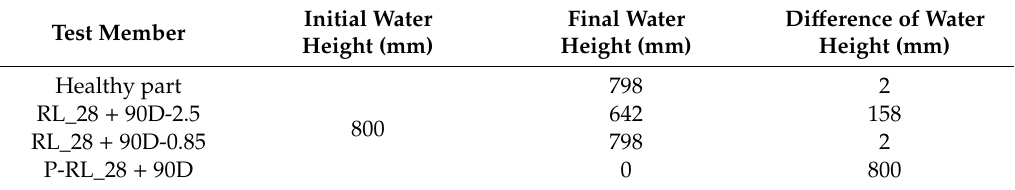
Table 10. Water flow test results.